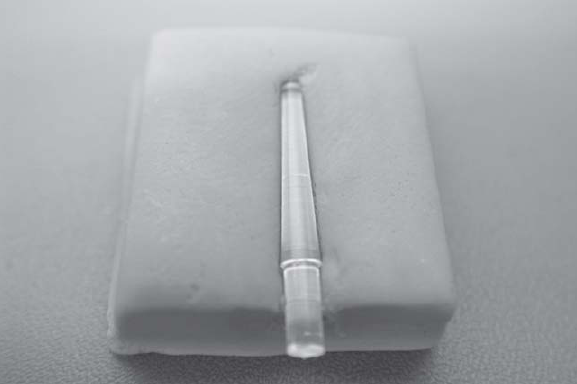
FIGURE 1- Radicular portion of template of addition silicone